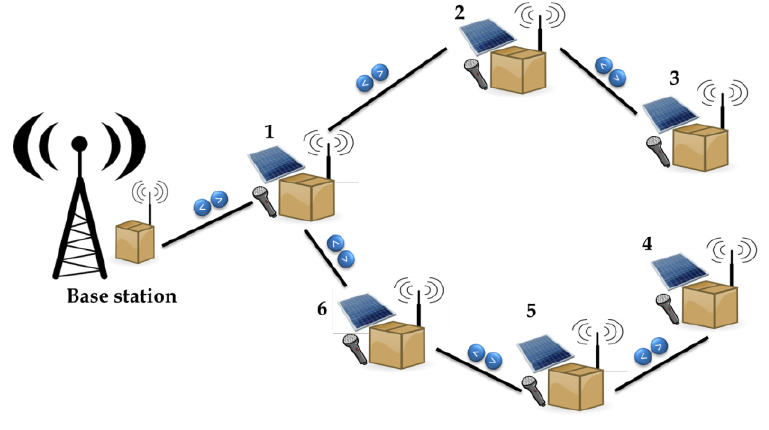
Figure 1. WSN architecture.